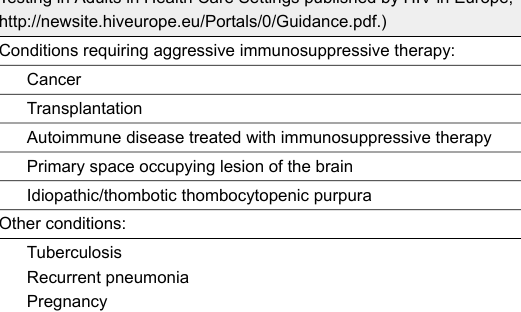
Table 2: Conditions in which not identifying the presence of human immunodeficiency virus (HIV) infection may have significant adverse implications for the individual’s clinical management. (This is Table 2c of the FOPH 2015 HIV testing recommendations together with indicator conditions listed in the Guidance for Implementing HIV Testing in Adults in Health Care Settings published by HIV in Europe,